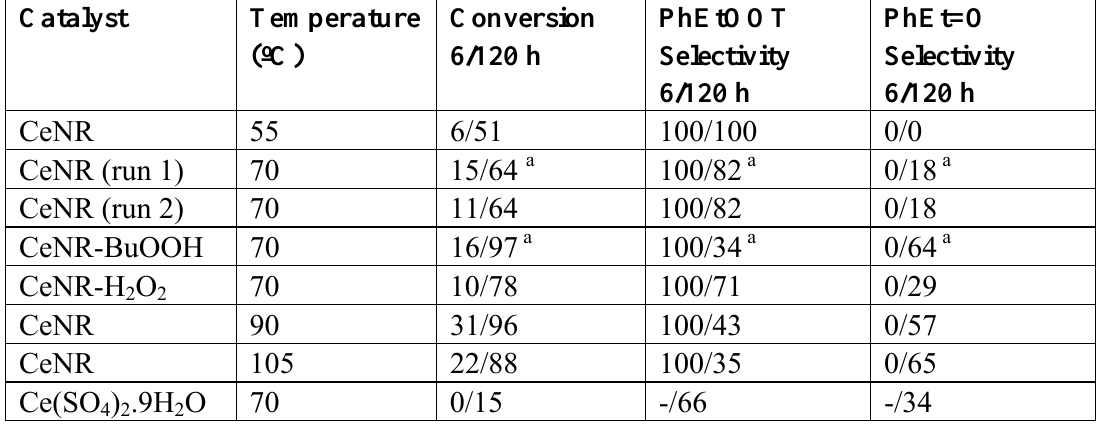
Table 2. Catalytic oxidation of PhEt with t -BuOOH, in the presence of the cerium-based